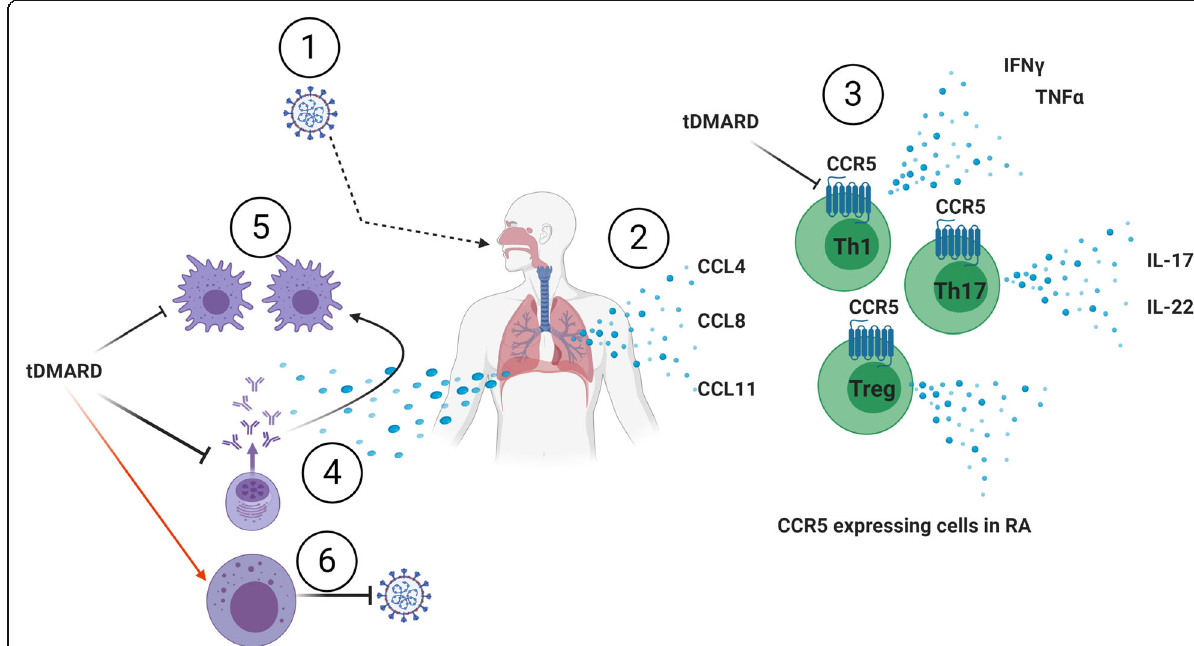
Fig. 6 A working hypothesis for tDMARDs and COVID-19 interactions. The possible role of (1) SARS-COV-2 infected lungs (2) chemokines in recruiting (3) CCR5 rich immune cells. Epithelial cells secrete three chemokines that recruit immune cells that stimulate Th17 and Th1 profile to kill the virus but recruit inflammatory to the area. Infected epithelium can stimulate (4) plasma cells to secrete antiviral Ab that can (5) stimulate local macrophages to have an inflammatory M1 profile. tDMARDs can be helpful in the COVID-19 scenario by blocking CCR5 expression on immune cells plus inhibiting plasma amd M1 macrophages while enhancing NK cells to kill the